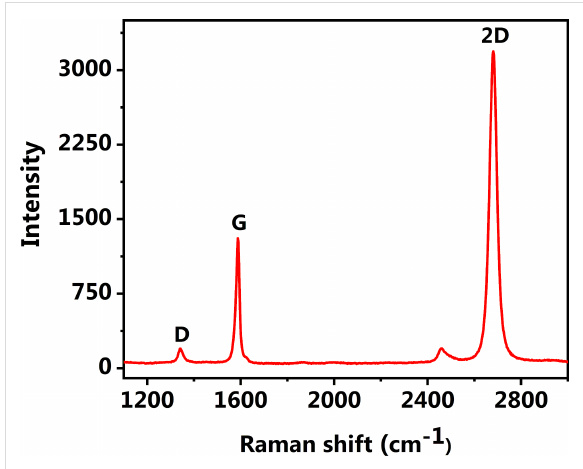
Figure 2: Raman spectrum of single-layer graphene on a SiO 2 /Si sub- strate used as a template for the deposition of the PbPc